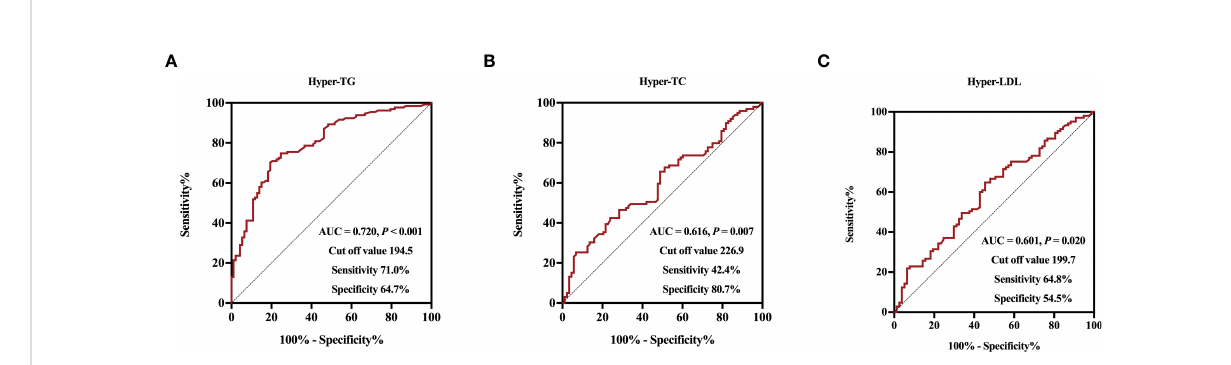
FIGURE 3 Receiver operative characteristic curves and cut off values of serum Metrnl levels for Hyper-TG (A) , Hyper-TC (B) , and Hyper-LDL (C)